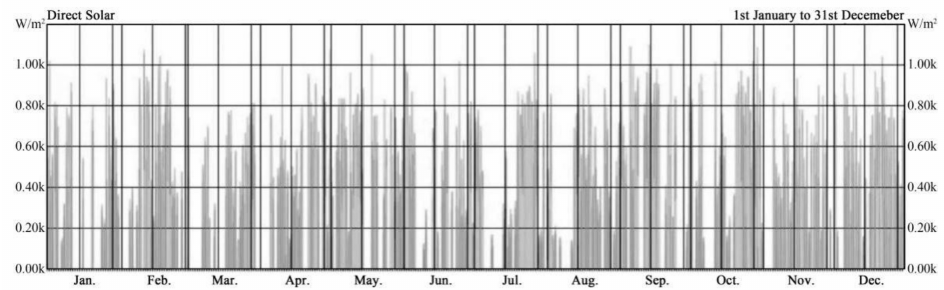
Figure 4. Daily direct sunlight in Hangzhou